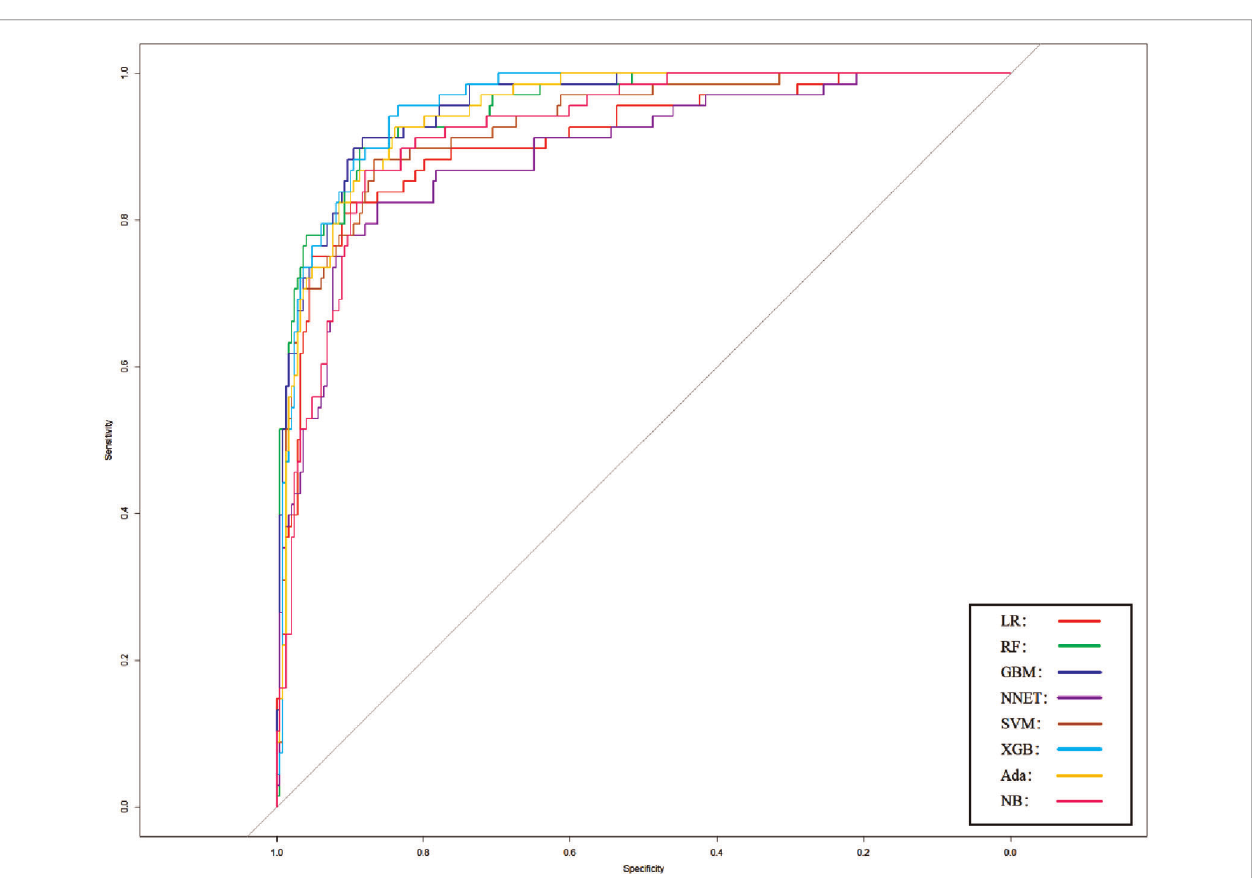
FIGURE 8 | Area under the receiver operating characteristic curve of different models of non-traumatic subarachnoid hemorrhage in the validation cohort. LR, logistic regression; RF, random forest; GBM, gradient boosting machine; NNET, arti fi cial neural network; SVM, support vector machine; XGB, eXtreme gradient boosting; Ada, adapting boosting; NB, naïve Bayes; the model was adjusted for GCS, glucose, sodium, chloride, SPO 2 , bicarbonate, temperature, white blood cell (WBC), heparin use, and SOFA